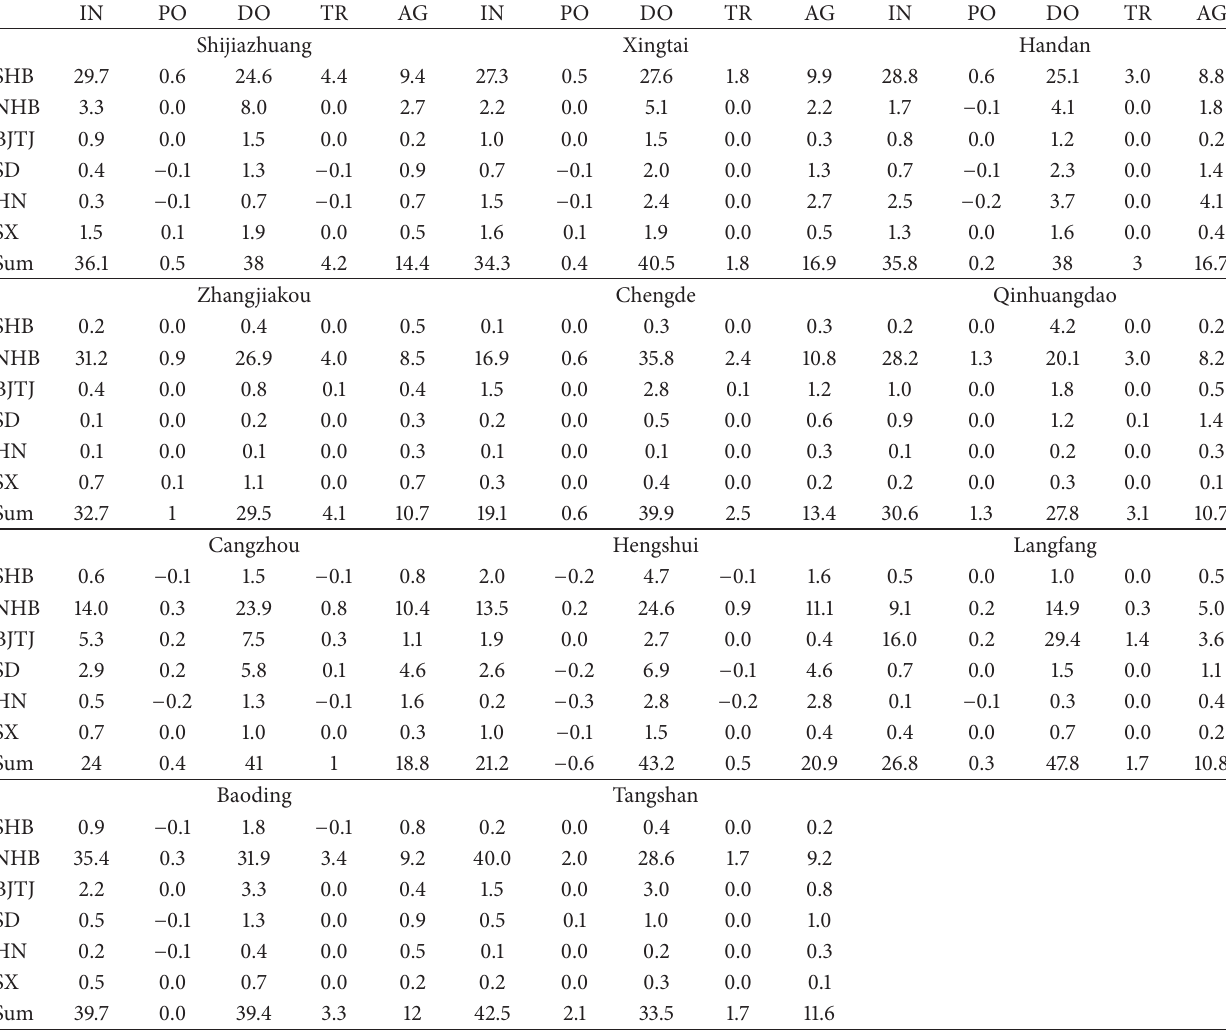
Table 4: The average source contributions (%) to PM 2.5 concentrations in Hebei cities by source regions and sectors from 1 January to 28 February